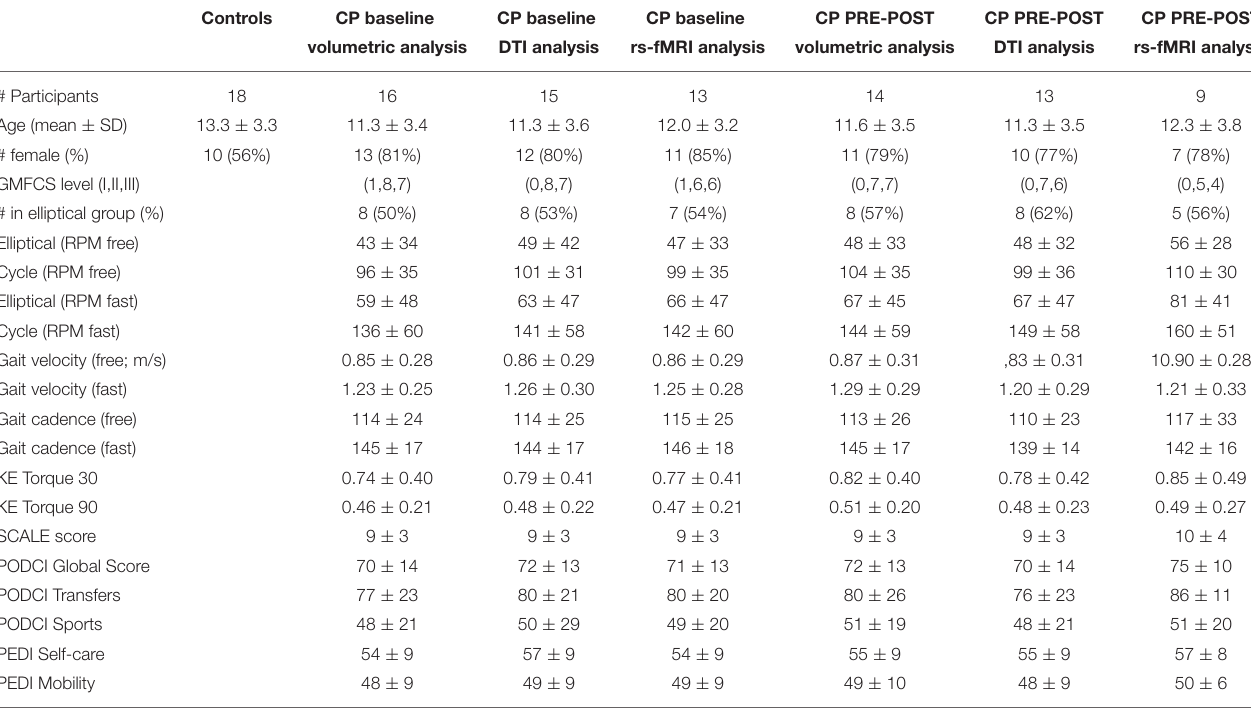
TABLE 1 | Participant demographic and baseline functional characteristics for the control group and CP imaging subgroups.